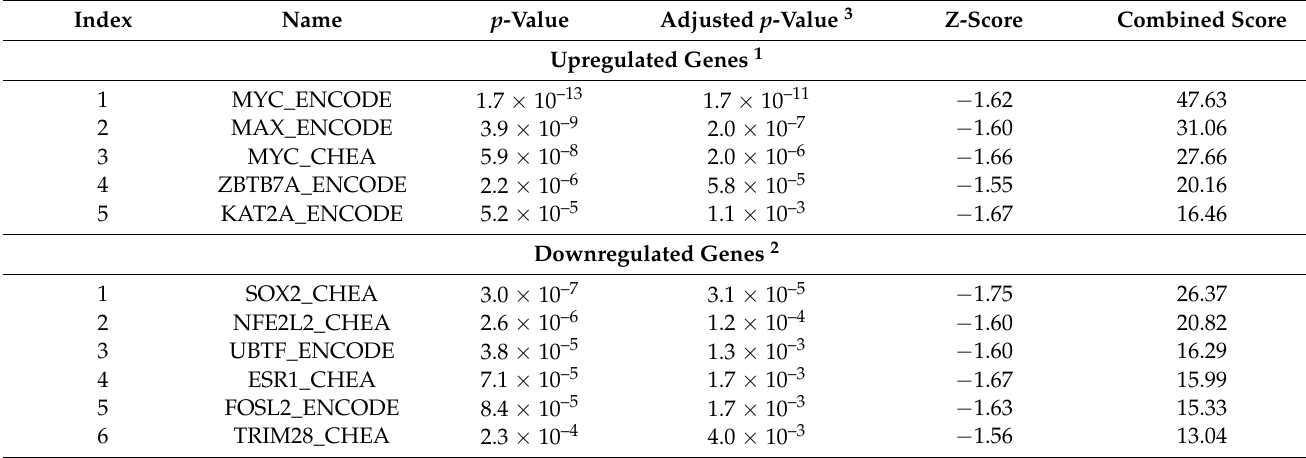
Table 2. Transcription factor enrichment analysis in sorafenib-resistant Huh7